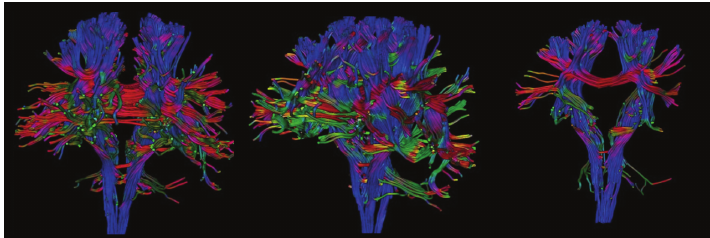
Figure 2: Three-dimensional tractography that reconstructs brain white matter bundles. The different colors represent different directions of the